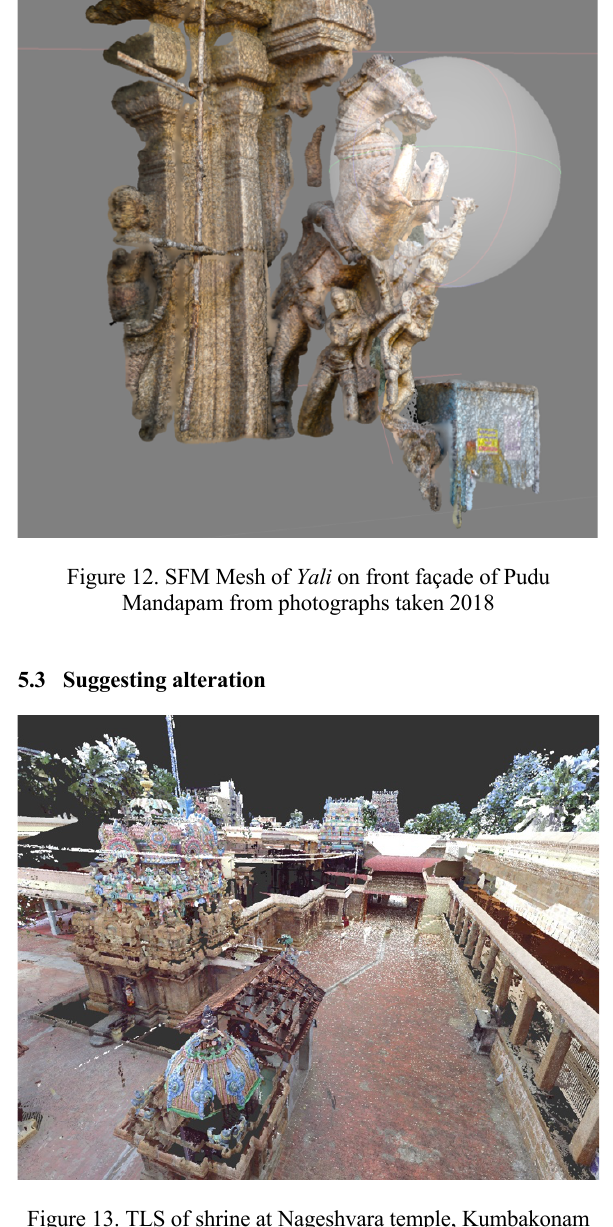
Figure 13. TLS of shrine at Nageshvara temple,